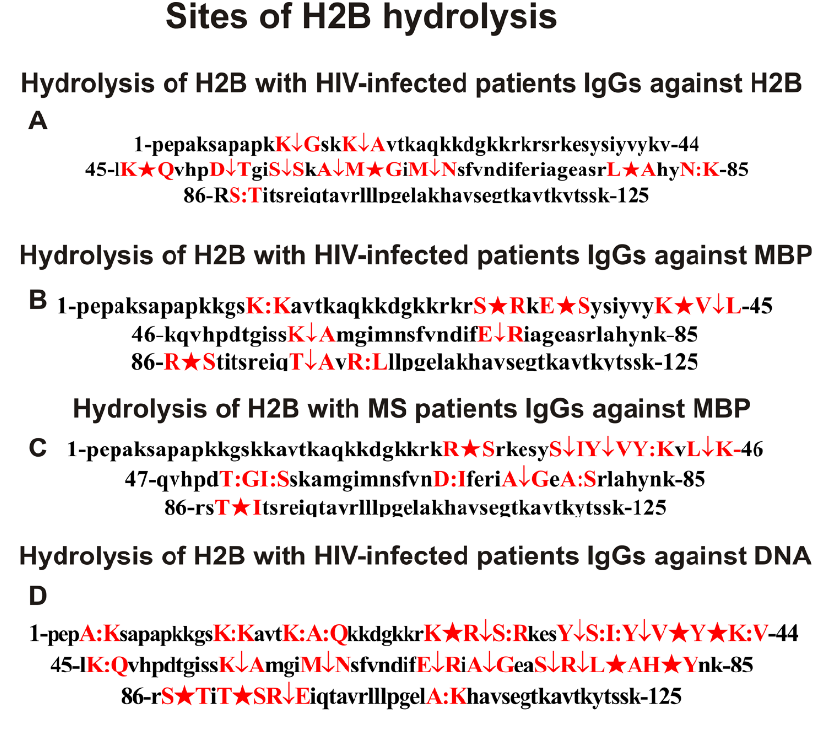
Figure 8. Sites of H2B hydrolysis by IgGs of HIV-infected patients against H2B ( A ), MBP ( B ), and DNA ( D ), as well as with Abs of MS patients against MBP ( C ). Major sites of H2B cleavage are marked by big stars ( ★ ), moderate ones by arrows ( ↓ ), and minor sites of the splitting by colons (:) ( A – D ). Clusters and sites of histone hydrolysis are shown in red. To simplify the analysis of common and different hydrolysis sites for all antibodies used, they are summarized in Table 1. Table 1. Sites of H2B histone hydrolysis by MS and HIV-infected patients IgGs against five histones, MBP, and DNA *.